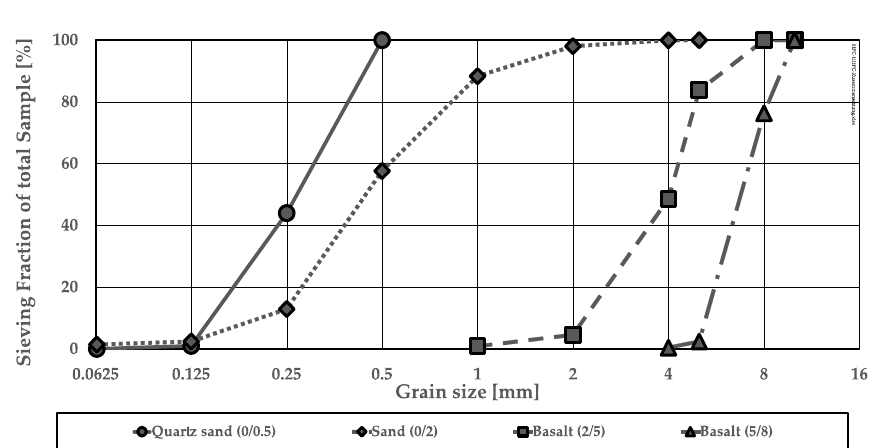
Figure A1. Grain size distribution of quartz sand, sand and basalt aggregate.